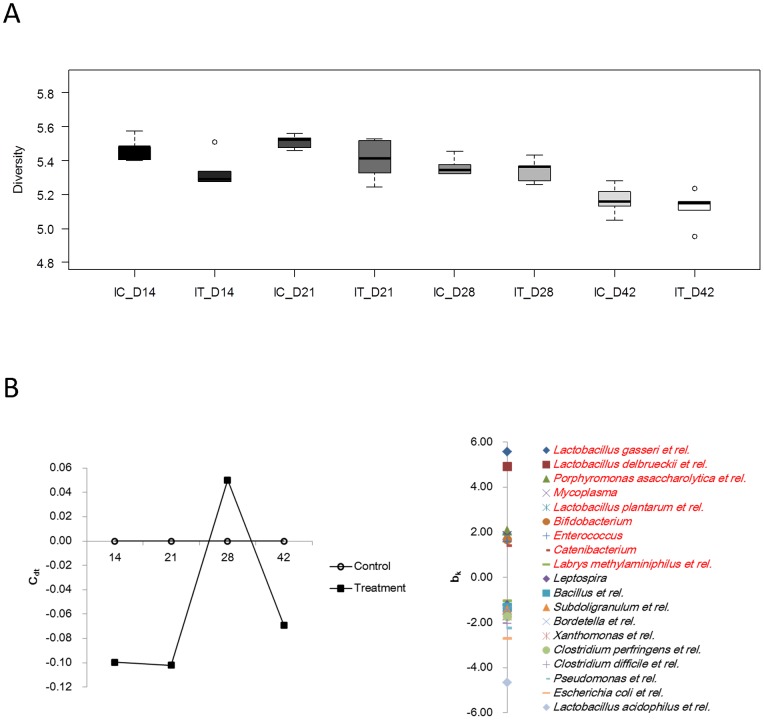
A. Diversity of offspring ileal microbiota expressed using the Shannon diversity index calculated based on probe-level signal intensities as implemented in the Microbiome package (http://microbiome.github.com). Maternal antibiotic treatment transiently reduced diversity on day 14 of age (P<0.05). B. Composition of offspring ileal microbiota was affected during the first weeks of life by maternal treatment, as evaluated by Principle Response Curve analysis of approximate genus-level microbial groups.